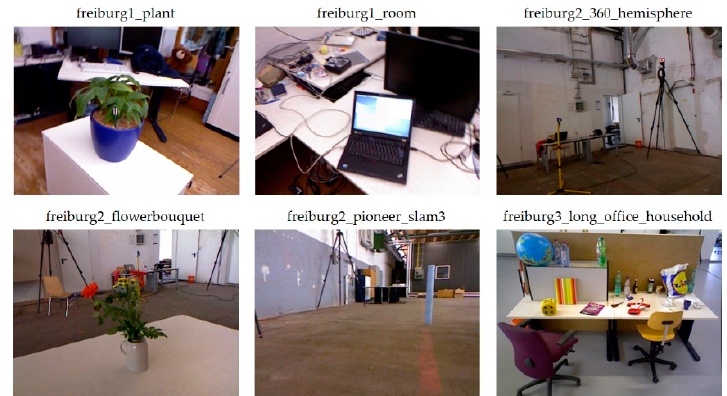
Figure 8. Six sequences of the TUM RGB-D dataset